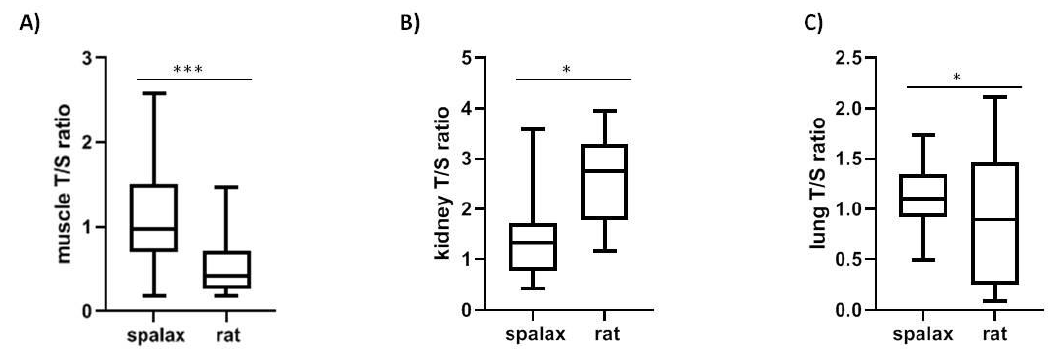
Figure 4. Telomere length in Spalax and rat in ( A ) muscle ( N = 15, p < 0.0001); ( B ) kidney ( N = 15, p < 0.05); ( C ) lung ( N = 16, p <